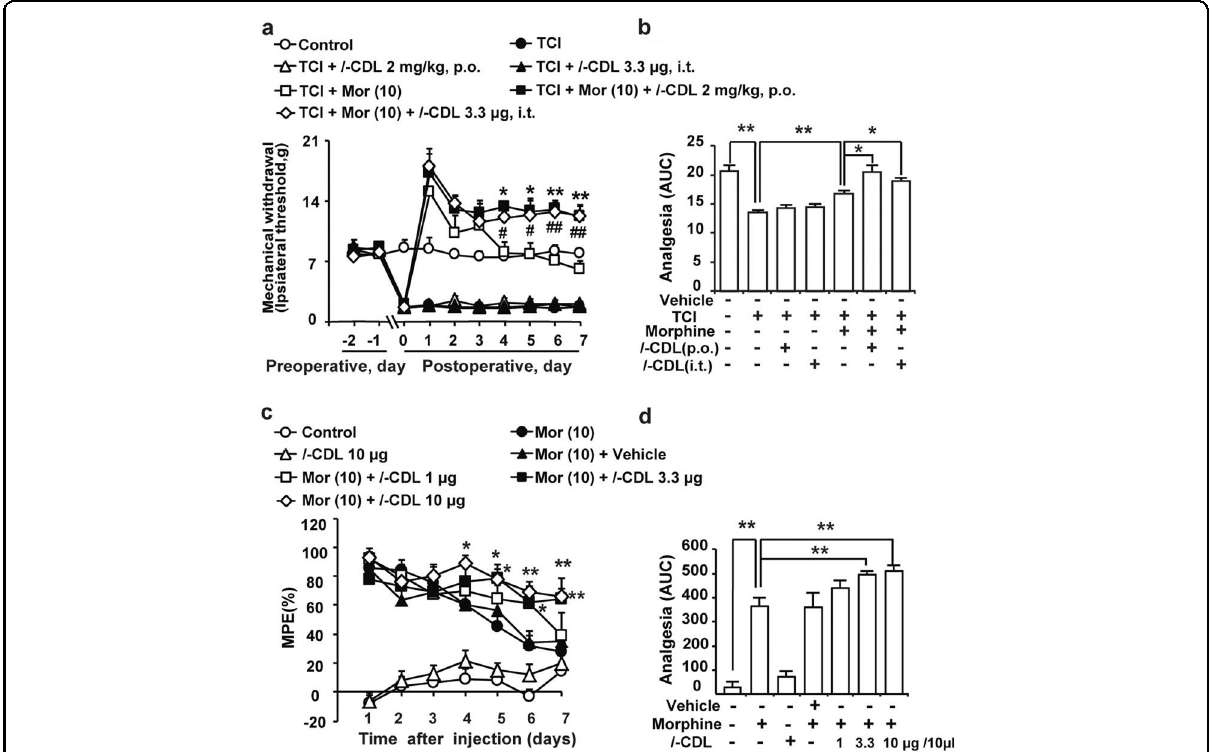
Fig. 1 Intrathecal administration of l- CDL attenuates morphine tolerance and antinociceptive effects. Rats and mice were examined daily with Von Frey fi laments and the tail- fl ick assay, respectively. Data are presented as percentages of the maximal possible effect (% MPE). The analgesic effect of morphine was decreased after the chronic morphine treatment, indicating the development of morphine tolerance. a l- CDL attenuated morphine tolerance in TCI rats at nonnarcotic analgesic doses. b The analgesia was further reported as area under the curve (AUC) units. Data are presented as means ± SE. n = 6, * P < 0.05, ** P < 0.01, # P < 0.05, ## P < 0.01 compared with the morphine group. c l -CDL attenuated the development of morphine tolerance and did not affect the pain threshold in naïve mice. d The analgesia was further reported in AUC units. Data are presented as means ± SE. n = 12, * P < 0.05, ** P < 0.01, compared with the morphine